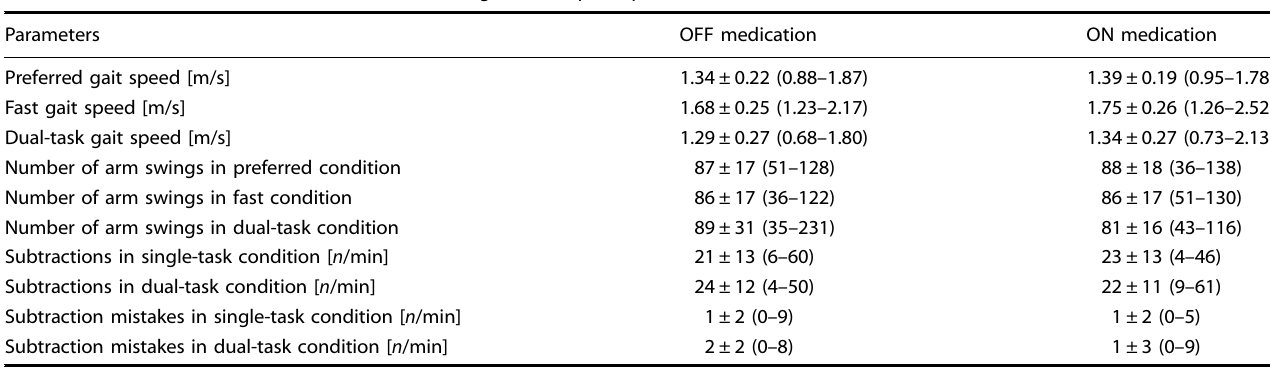
Table 2. Performance (mean ± standard deviation (range)) of the participants.